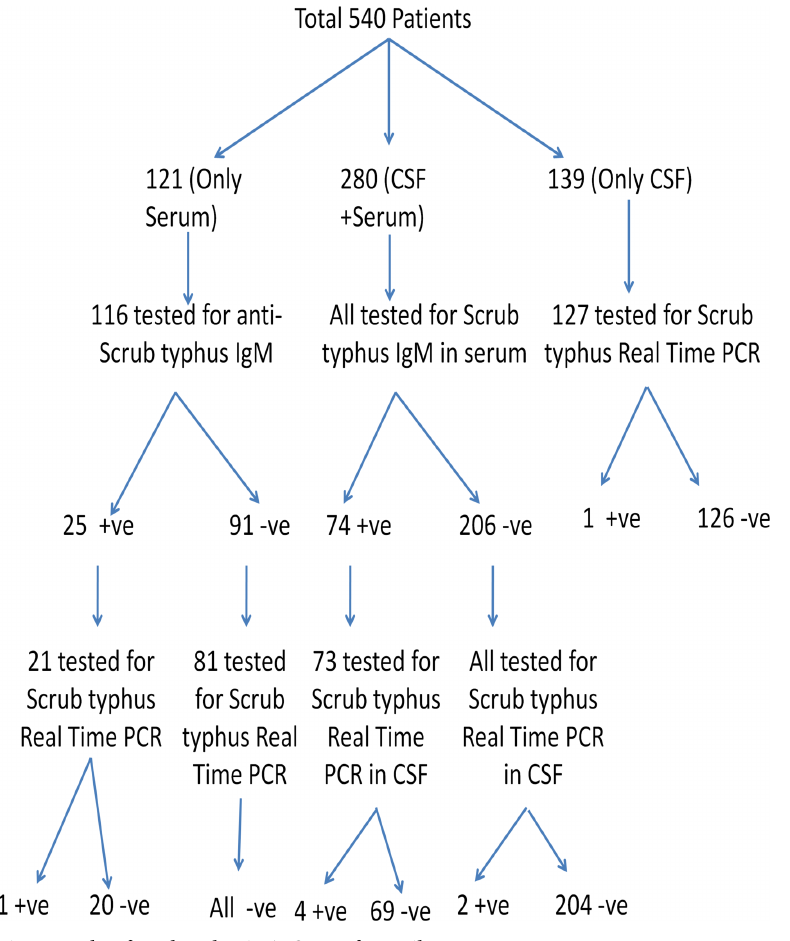
Fig 2. Results of scrub typhus in AES cases from